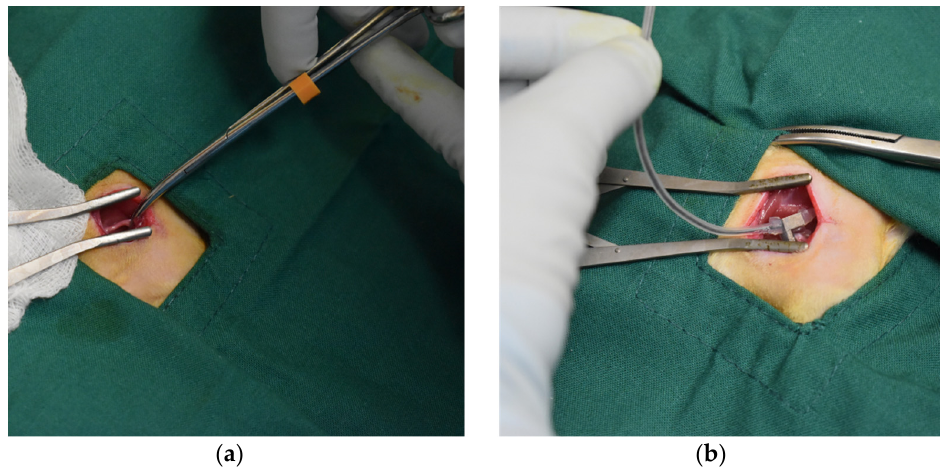
Figure 3. Sciatic nerve compression on the right hind limb was conducted with ( a ) the conventional steel haemostats and ( b ) the soft robotic surgical gripper device. steel haemostats and ( b ) the soft robotic surgical gripper